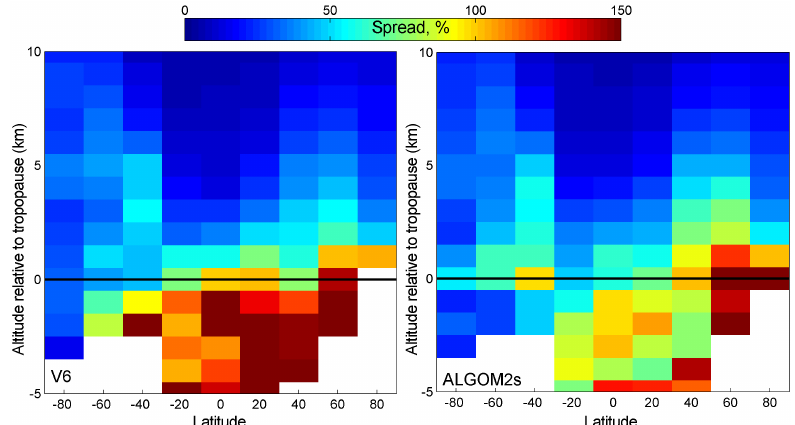
Figure 12. Spread in % of relative differences with respect to ozonesonde profiles for GOMOS V6 (left) and GOMOS ALGOM2s retrievals (right).